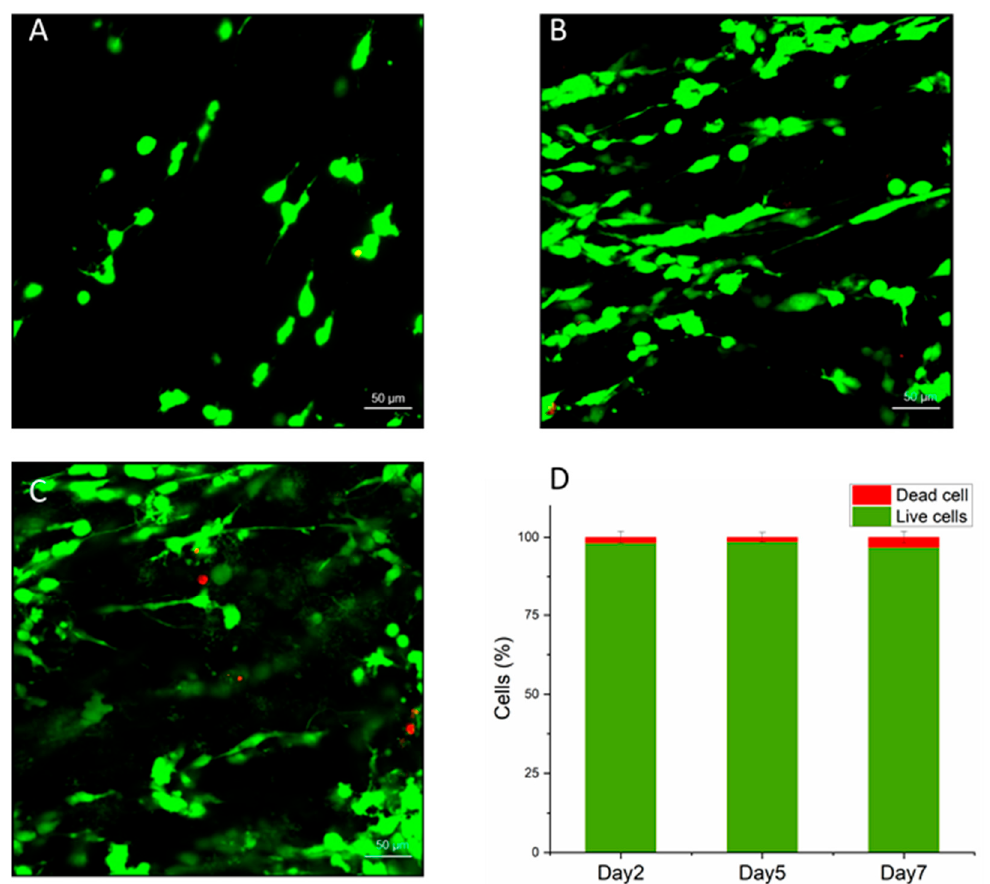
Figure 2. Viability and proliferation of SH-SY5Y cells in the m-rGO/collagen hydrogel scaffold. ( A ) Representative confocal fluorescence images of live and dead SH-SY5Y cells in the construct for 2 days ( A ), 5 days ( B ), and 7 days ( C ). ( D ) Quantification of cell viability.